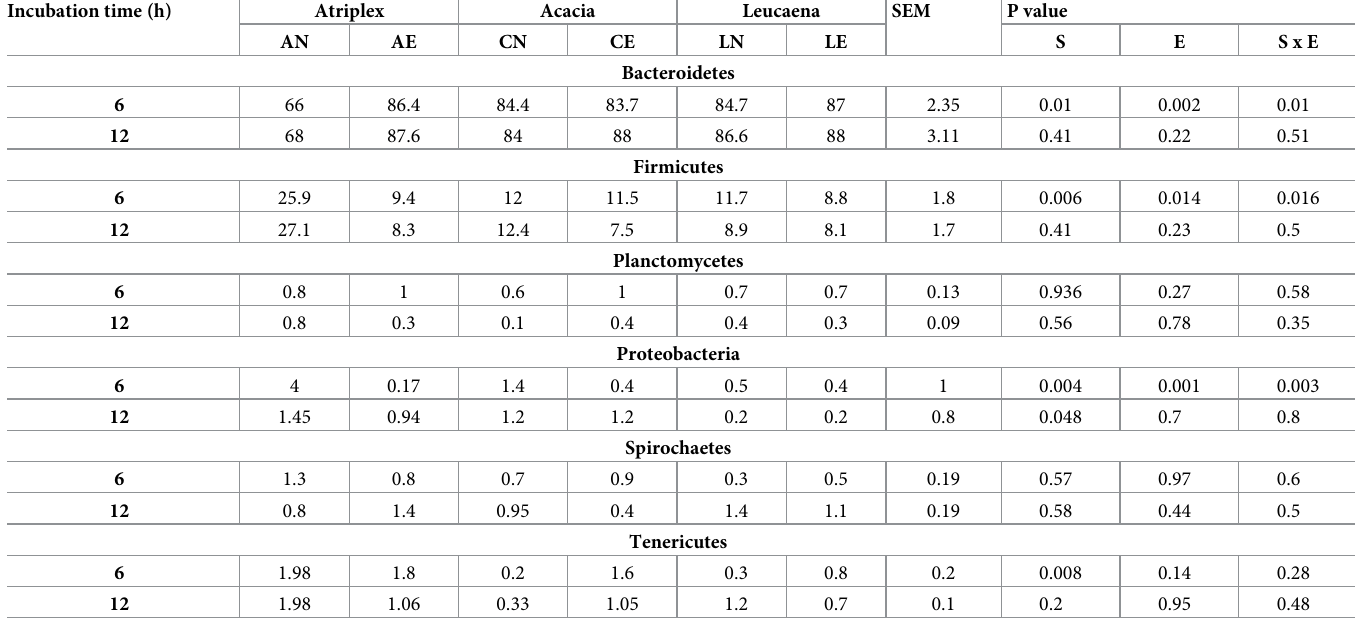
Table 4. The average of relative abundance (%) of dominant bacterial phyla colonized to extracted and non-extracted atriplex, acacia, and leucaena at 6 and 12 hours incubations. Incubation time (h)